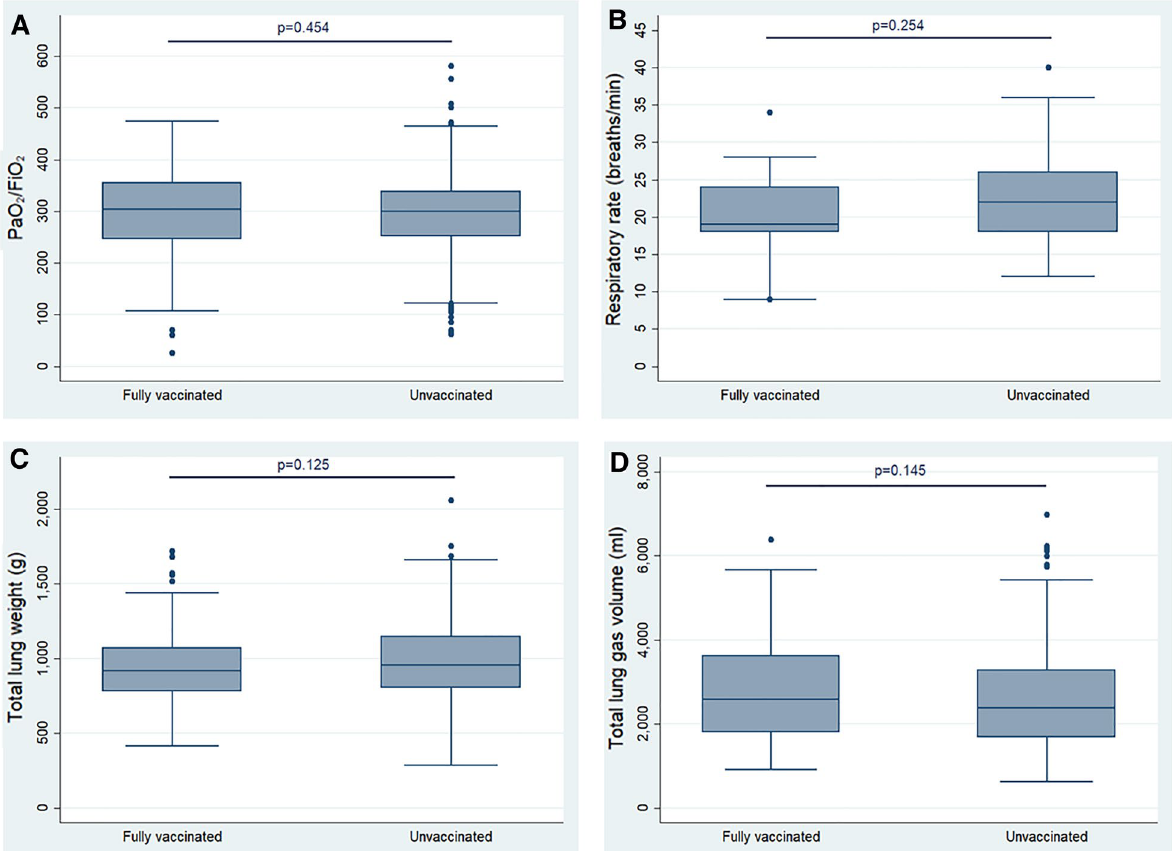
Fig. 1 Comparisons between fully vaccinated and not vaccinated (unvaccinated) patients in PaO 2 /FiO 2 ( A ), respiratory rate ( B ), total lung weight ( C ) and total lung gas volume ( D ). Continuous variables were compared using Mann–Whitney U